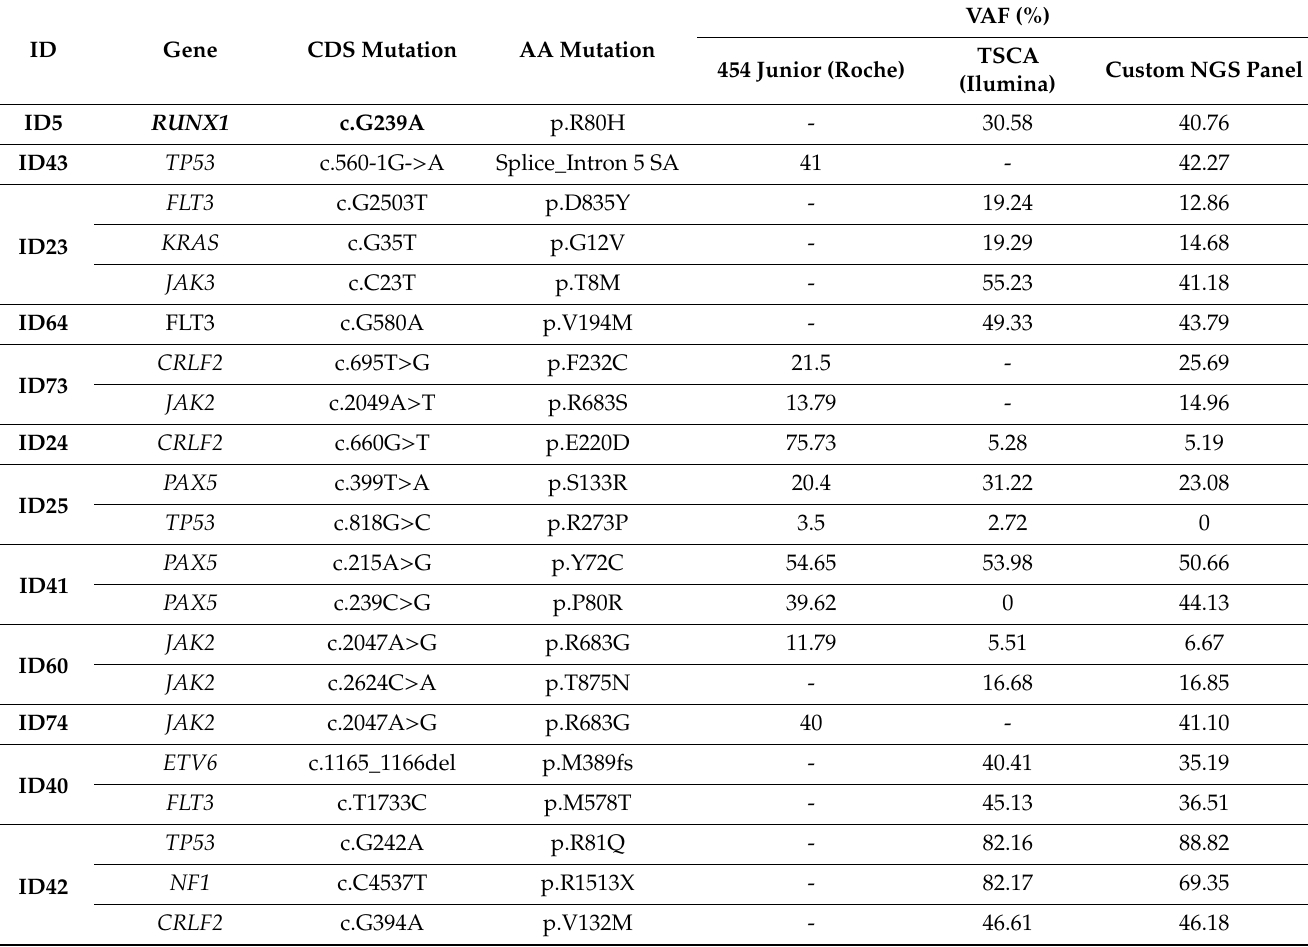
Table 1. Correlation between mutations detected by the custom NGS panel and 454 Junior sequencing. The table lists the patients who presented some mutations in the genes studied by sequencing with 454 Junior. The first column contains the patient identifier (ID) in bold, followed by the gene, altered nucleotide in coding sequence (CDS mutation), an altered amino acid (AA mutation), and variant allele frequency (VAF) detected by 454 Junior sequencing and the custom NGS